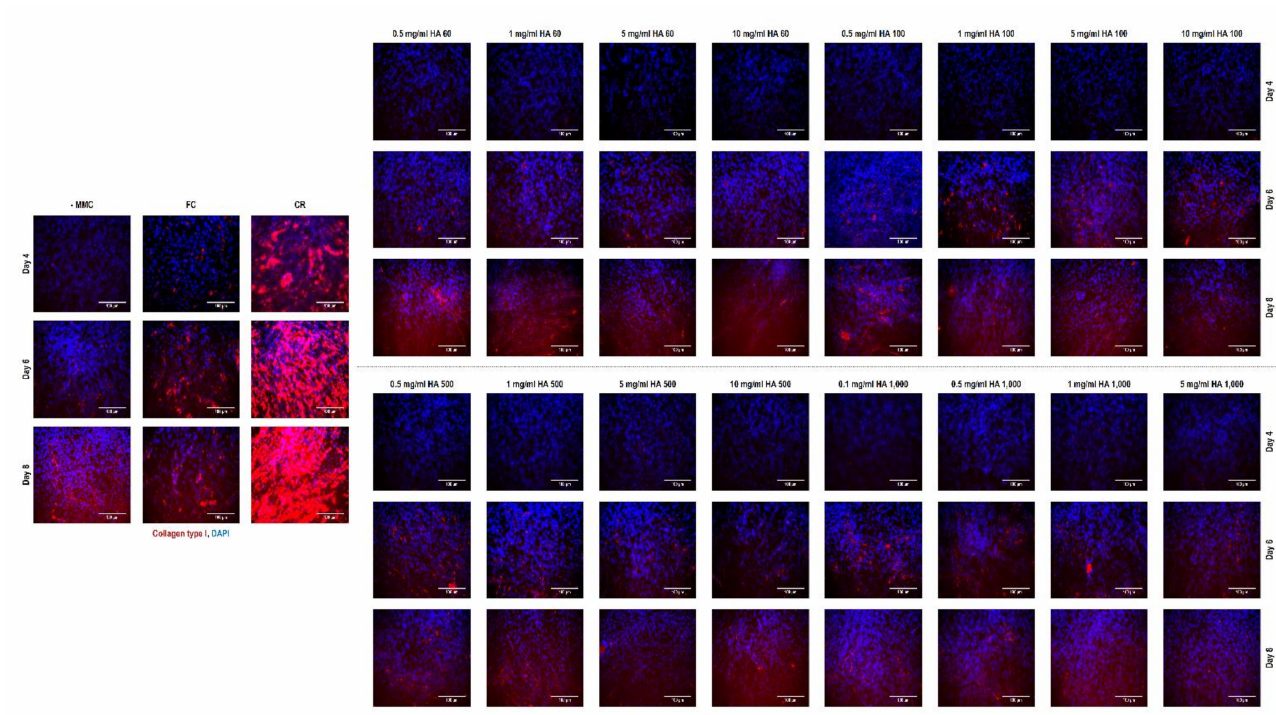
Figure 2. Immunocytochemistry analysis revealed that carrageenan induced the highest collagen type I deposition at all timepoints and at day 8 (longest timepoint assessed), no differences were observed between the non-MMC group and the Ficoll ® and any of the HA